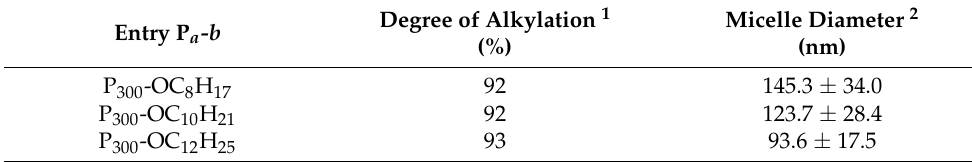
Table 4. Dependence of micelle diameter of POEAP from alkyl chain